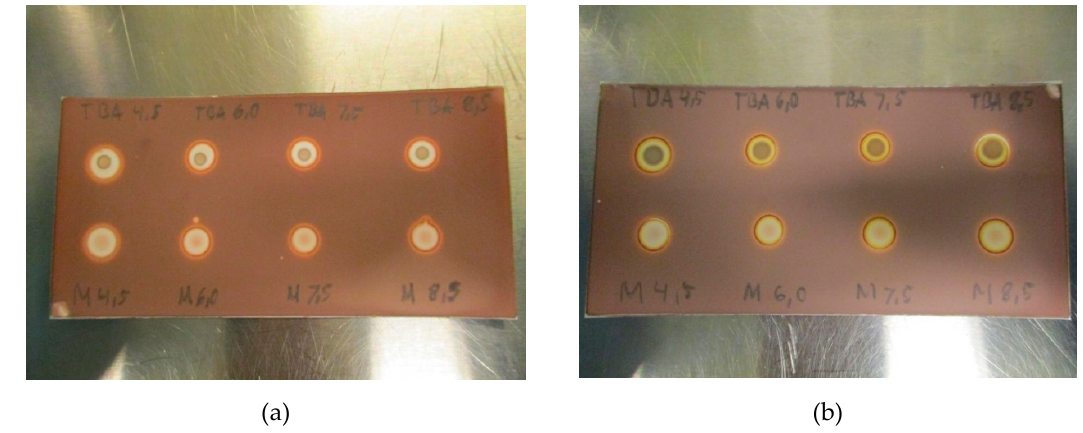
Figure 4. ( a ): TBA and matrix spots pH-range 4.5–8–5 for [ 18 F]PSMA-1007 without antioxidant and ( b ): TBA and matrix spots pH-range 4.5–8–5 for [ 18 F]PSMA-1007 with antioxidant.